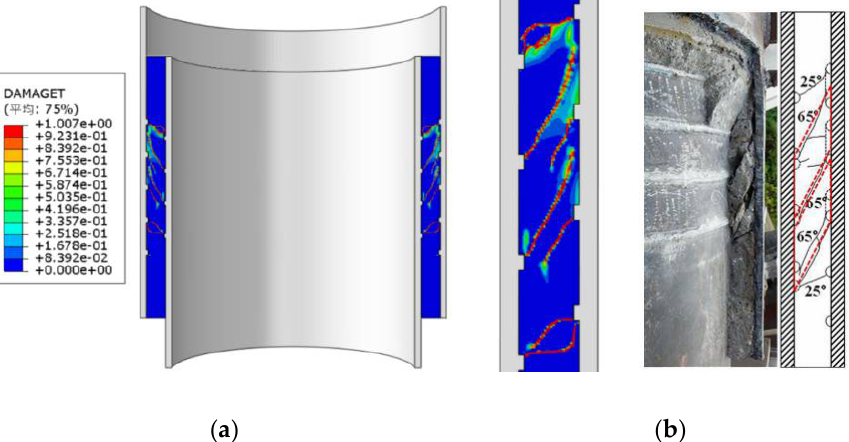
Figure 7. Comparison of the cloud diagram of grout’s tensile damage with the experimental damage. ( a ) Cloud diagram of tensile damage. ( b ) Comparison of fracture morphology.